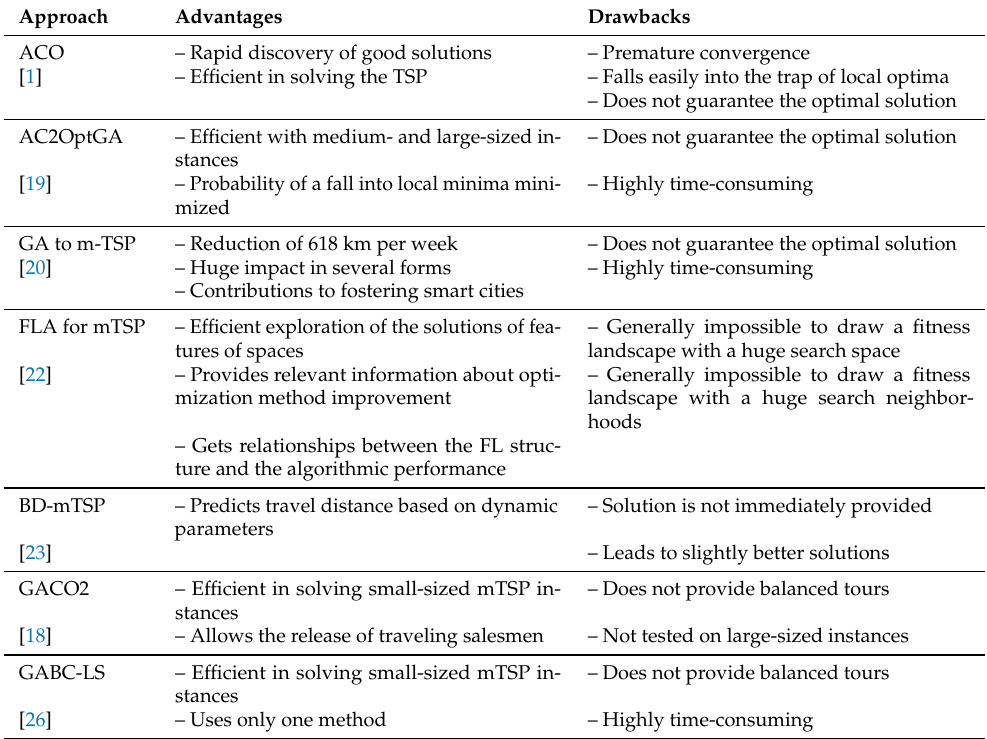
Table 1. Advantages and drawbacks of the reviewed